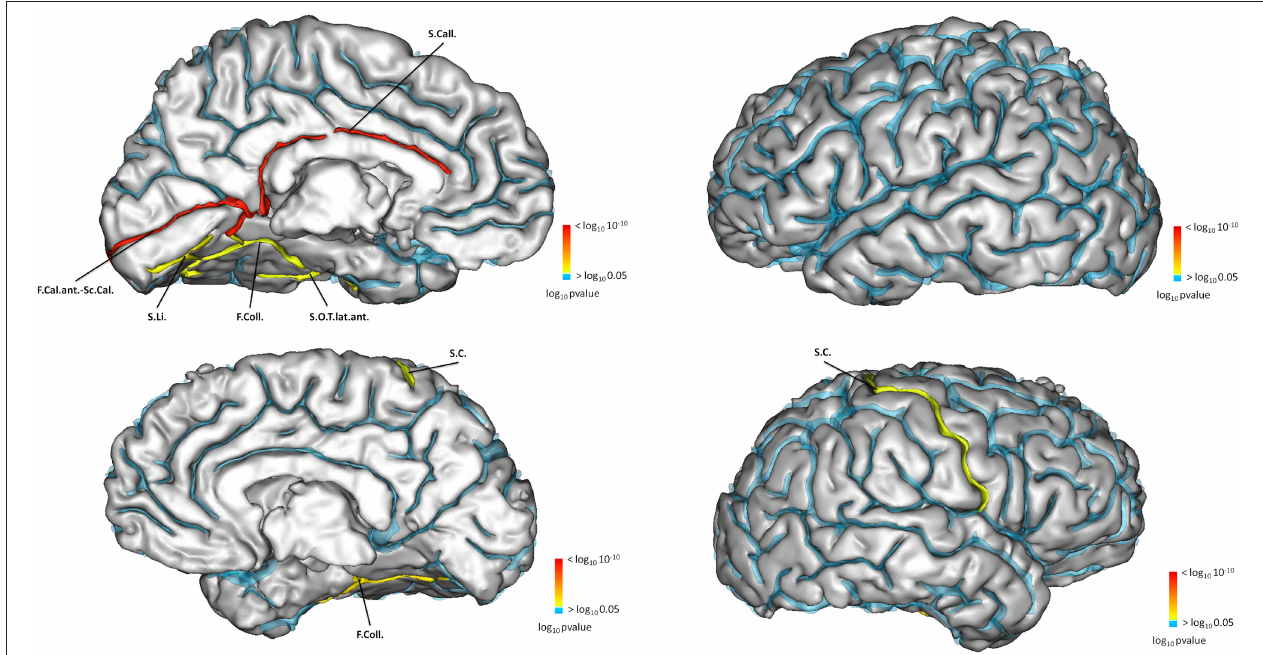
FIGURE 5 | Sulci of the left hemisphere (top) significantly different for left hippocampi with or without IHI. Sulci of the right hemisphere (bottom) significantly different between right hippocampi with or without IHI. The color map indicates the value of the corrected p -value. p > 0.05 are in blue.